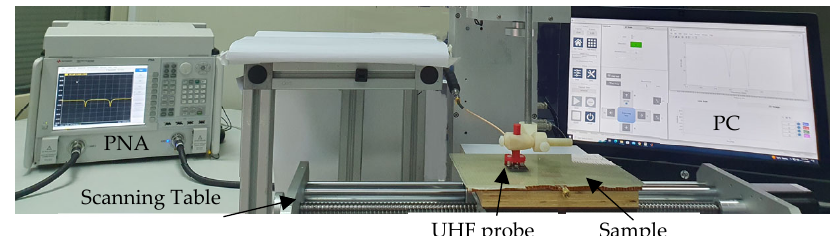
Figure 8. Photograph of the imaging setup.